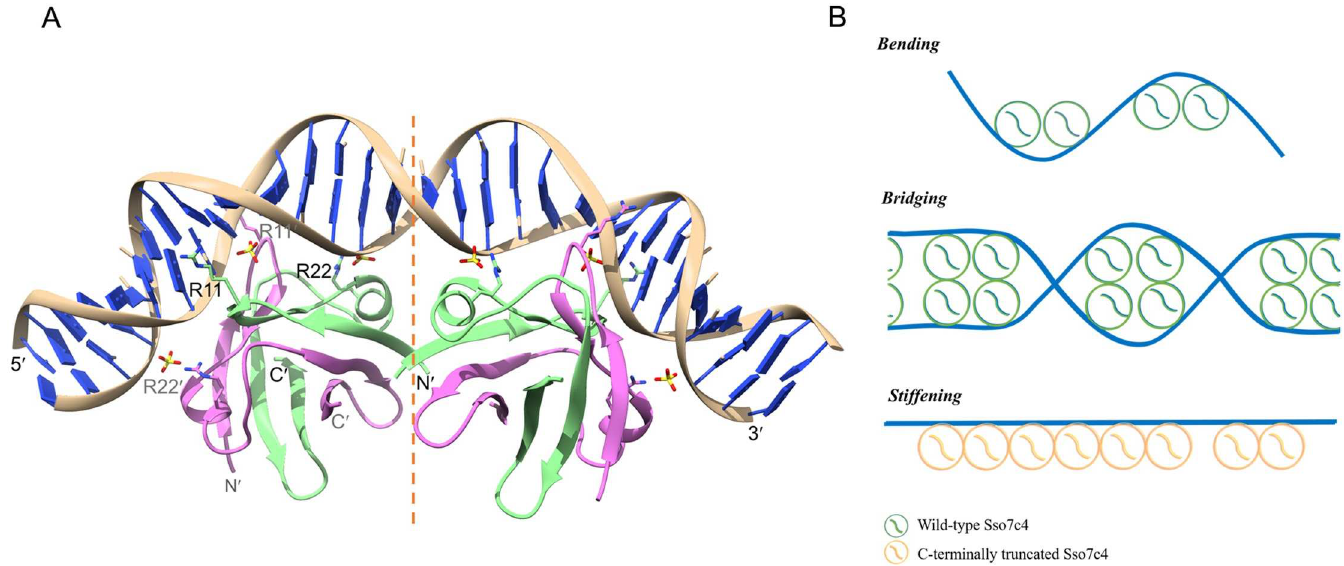
Fig 5. Model of the interaction of Sso7c4with DNA. (A)The DNA-binding surface of the Sso7c4 dimer was manuallydocked into the major groove such that the sulfates were locatedas close as possibleto the phosphates in the DNA backbone.A symmetrically bent DNA conformation was constructed using a known curved DNA (from the CAP-DNA complex; 1O3T). A brief minimizationwas performed to remove steric hindrance betweenthe protein side chains and DNA. (B) The models of three DNA bindingmodes inducedby Sso7c4 variants. The wild-typeSso7c4 binds to DNA in two different modes, bendingand bridging.In contrast, the C-terminally truncated Sso7c4 binds side-by-side along the DNA moleculeleadingto DNA stiffening.